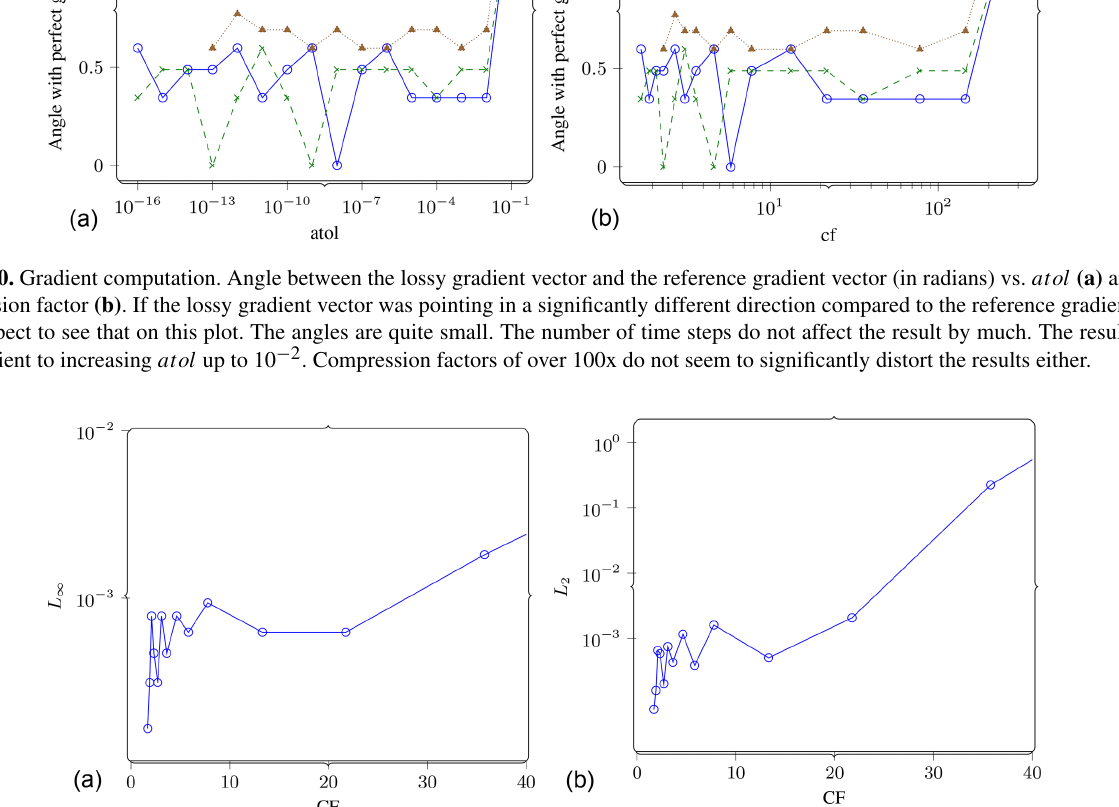
Figure 11. Gradient error. L ∞ (a) and L 2 (b) norms of the gradient error as a function of the achieved compression factor (CF). It can be seen that error is negligible in the range of CF up to 16. Figure 19 repeats a part of these results to aid comparison with the subsampling